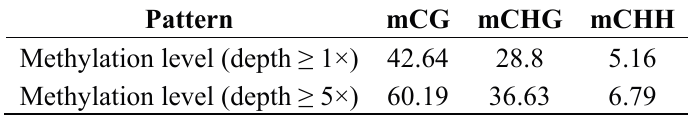
Table 3. DNA methylation pattern in Betula platyphylla at difference depths.